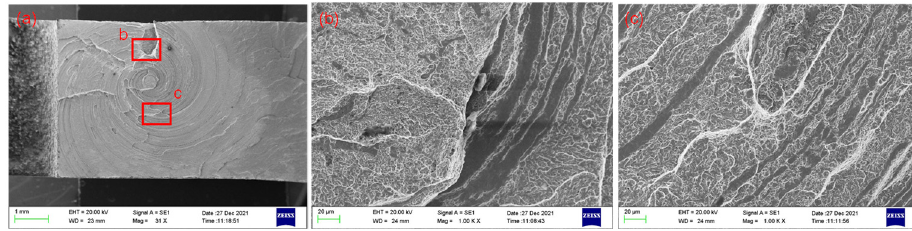
Figure 12. SEM fractography of an impact specimen (G3): ( a ) overall morphology, ( b ) fracture initiation zone, ( c ) fracture propagation zone, ( b , c ) are the high magnification of b, c in ( a ).